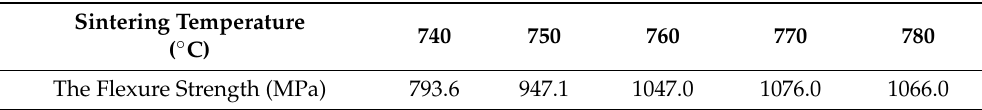
Table 2. Flexural strength of SD/Cu-Fe sandwich composite.